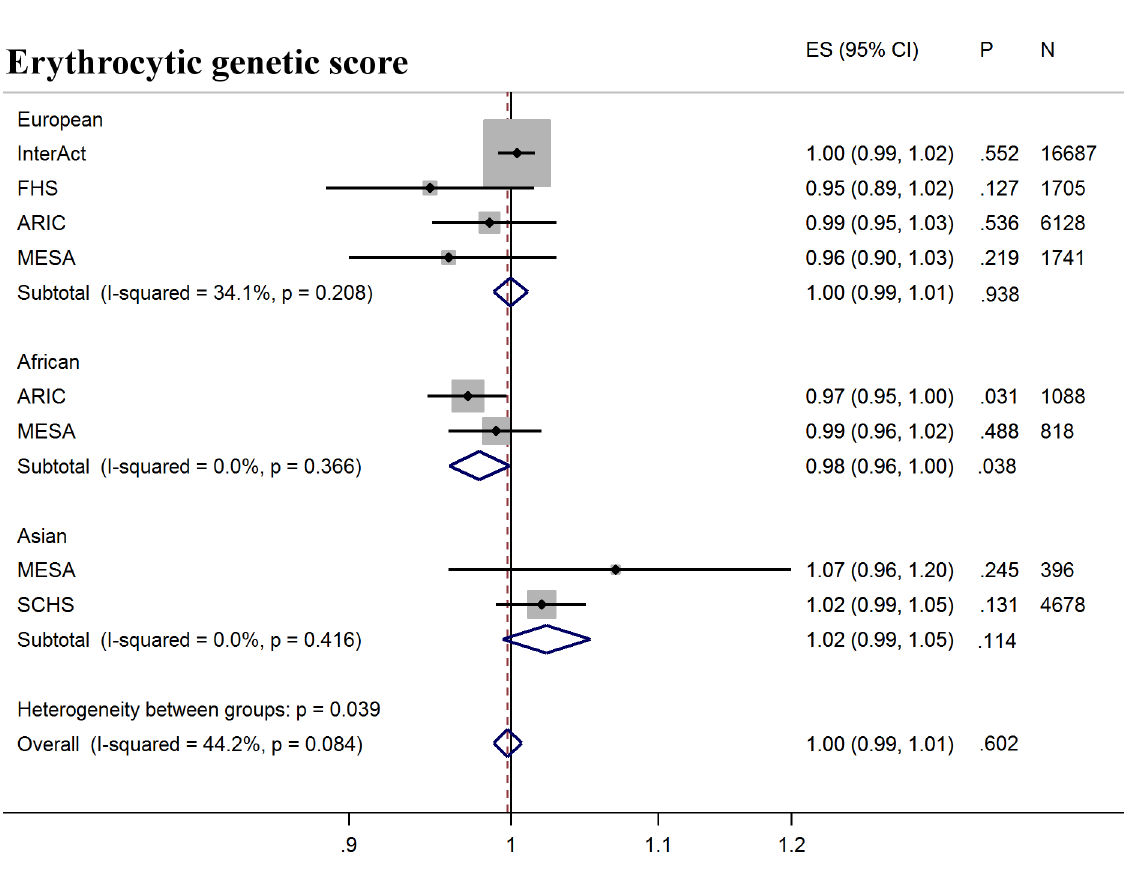
Fig 3. T2D prediction, erythrocytic genetic score. Forest plot of association betweenerythrocytic geneticscore with incident T2D over a decade-long follow-upperiod, by ancestry. MESA (European and Asian ancestry) and the G6PD variant (rs1050828) in ARIC (European and African American) were not includedin the discovery GWAS analysis. Effect estimates were combinedin a fixed effects meta-analysis. Overall effect estimate: 1.00, 95% CI 0.99–1.01, p = 0.60. ARIC, Atherosclerosis Risk in Communities Study; ES, Effect Size, FHS, Framingham Heart Study; GWAS, genome-wide associationstudy; G6PD, glucose-6-phosphate dehydrogenase; I-Squared, Higgin’sI-squared statistic, a measureof heterogeneity; MESA, Multiethnic Study of Atherosclerosis; SCHS, SingaporeChineseHealth Study; T2D, type 2